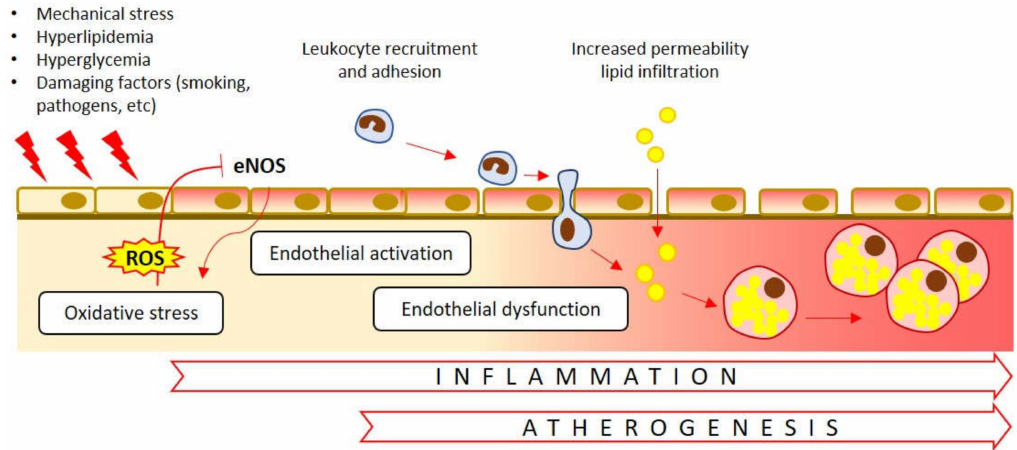
Figure 2. Endothelial dysfunction in atherosclerosis. Oxidative stress causes inhibition (T-bar) of the endothelial nitric oxide synthase (eNOS). Dysfunctional eNOS, in turn, further contributes to ROS formation (arrows). A number of other internal and external damaging factors impact the endothelial cells. Activation of the endothelial cells is associated with recruitment and adhesion of the immune cells, their penetration into the subendothelial space and initiation of the inflammatory response. Increased permeability of dysfunctional endothelium facilitates lipid entry into the arterial